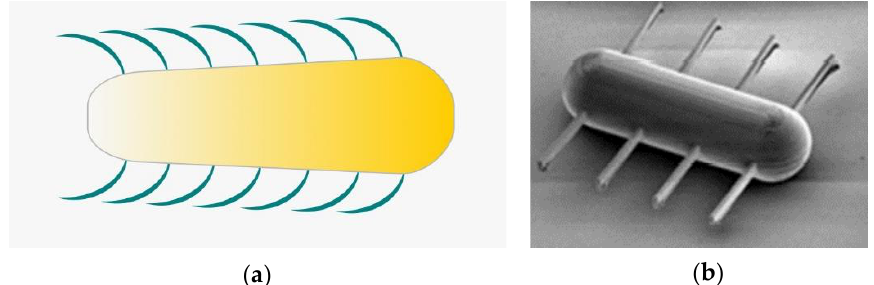
Figure 6. Ciliary microrobots: ( a ) Schematic of a microrobot inspired by cilia; ( b ) a SEM image of a ciliary microrobot [108].